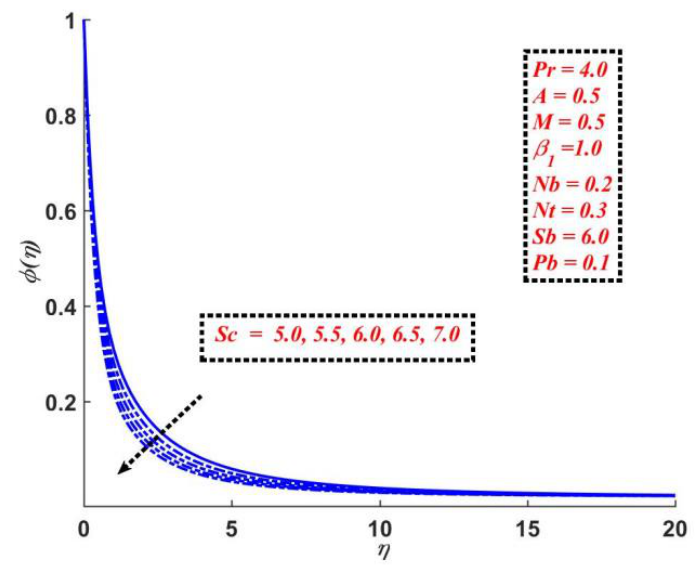
Figure 11. Influence of the Schmidt number on 𝜙(𝜂) .